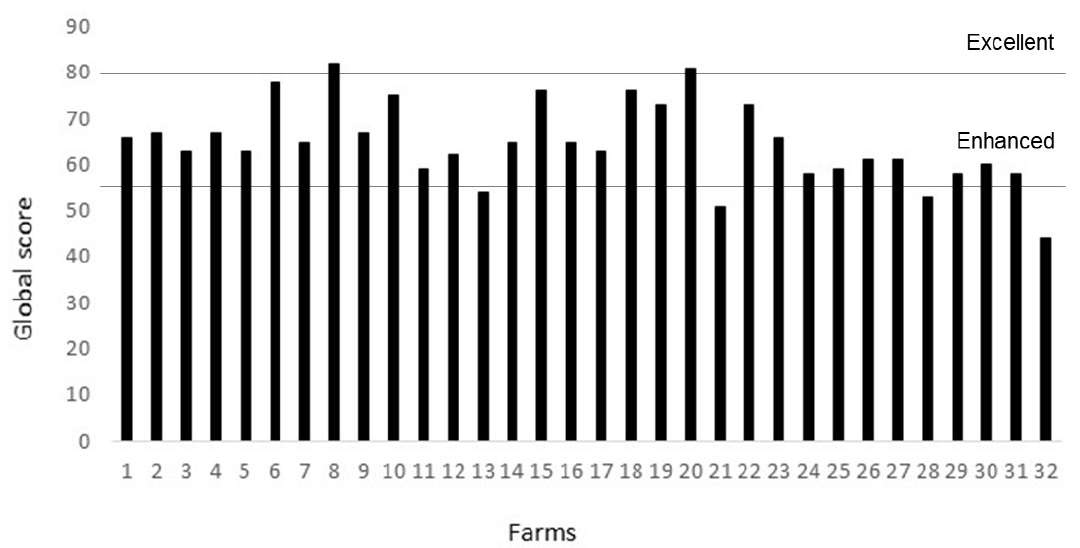
Figure 3. Overall welfare assessment scores, out of a possible 100, for 32 growing-rabbit farms located in Spain and Portugal.